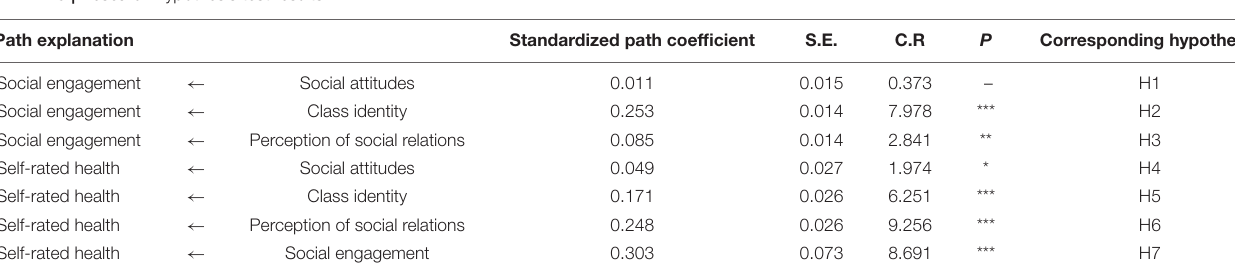
TABLE 5 | Research hypothesis test